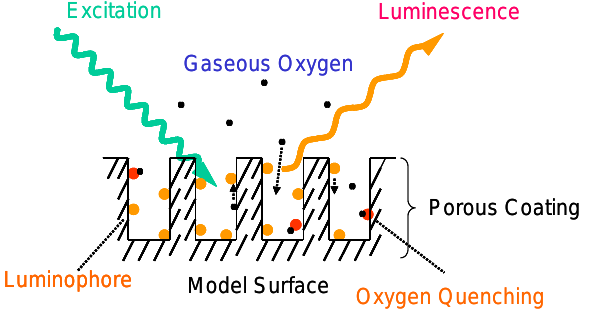
Figure 2. Schematic description of anodized-aluminum pressure-sensitive paint